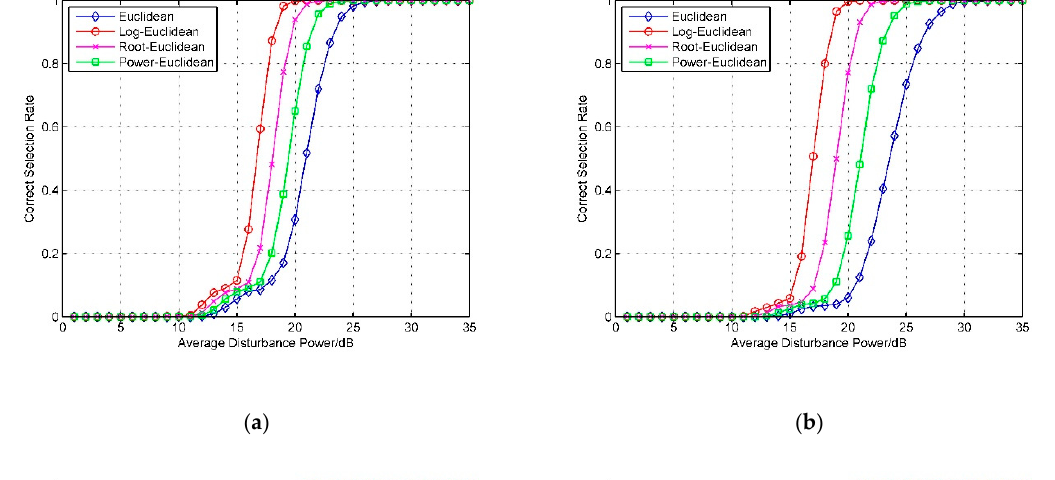
= 0.20, p = 1, number of 0 c